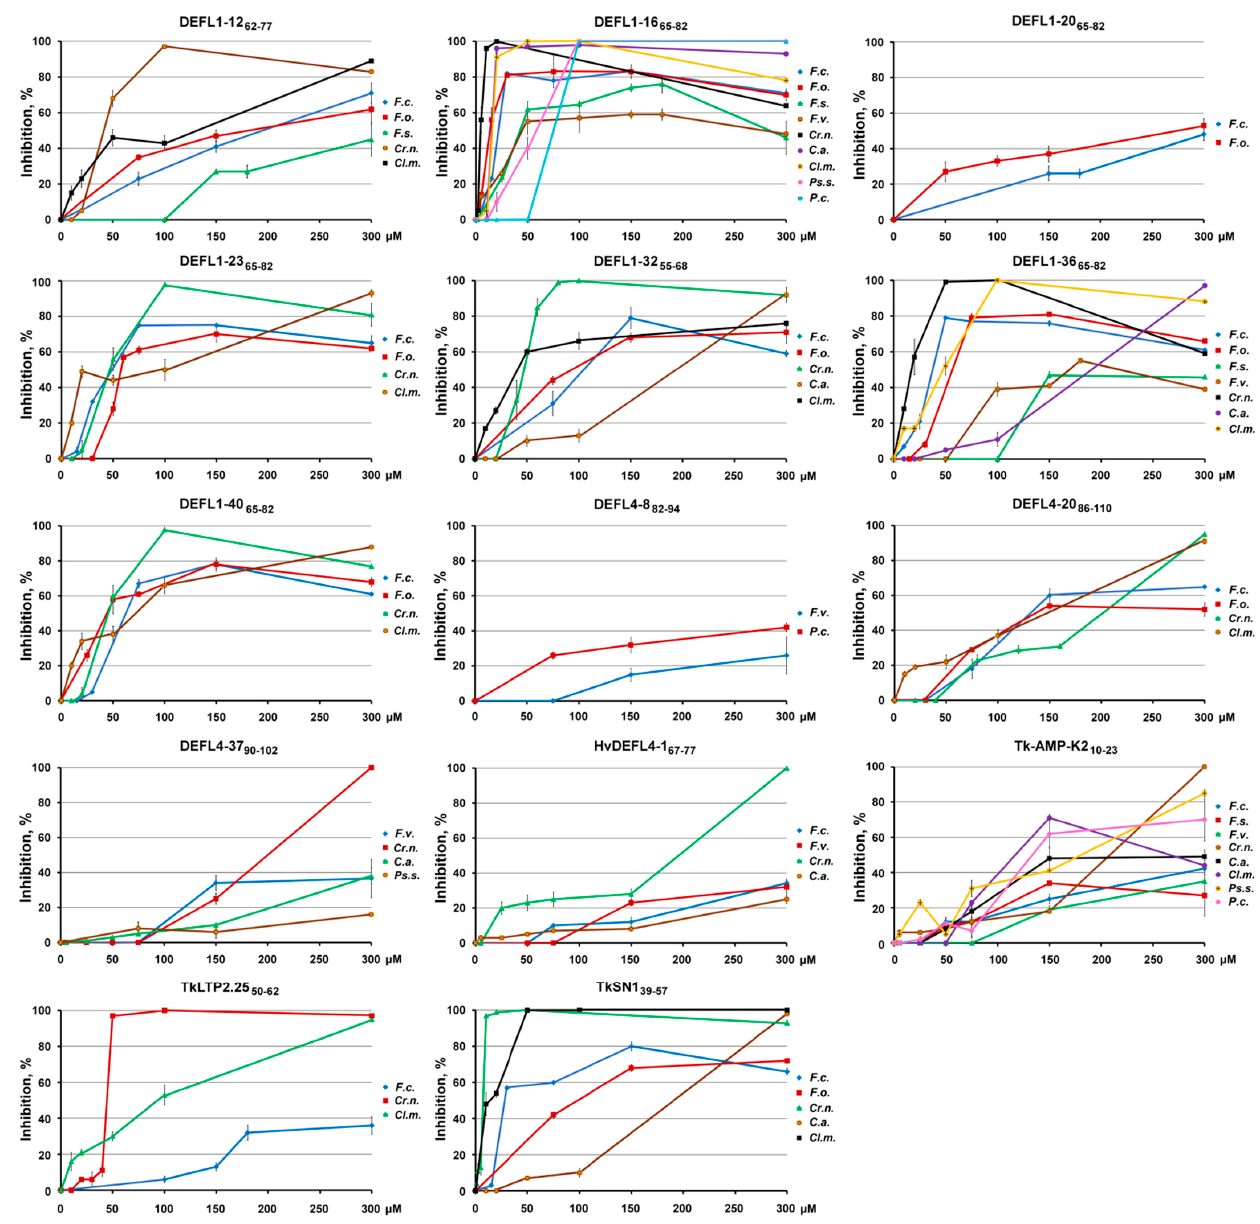
Figure 4. Inhibition curves of pathogenic microorganisms in the presence of different concentrations of γ -core motif peptides (relative to control, %). Error bars represent the SD of technical triplicates. The following abbreviations were used: F.c. for F. culmorum ; F.o. , F. oxysporum ; F.s. , F. solani ; F.v. , F. verticillioides ; Cr.n. , Cr. neoformans ; C.a. , C. albicans ; Cl.m. , Cl. michiganensis ; Ps.s., Ps. savastanoi ; and P.c., P. carotovorum .